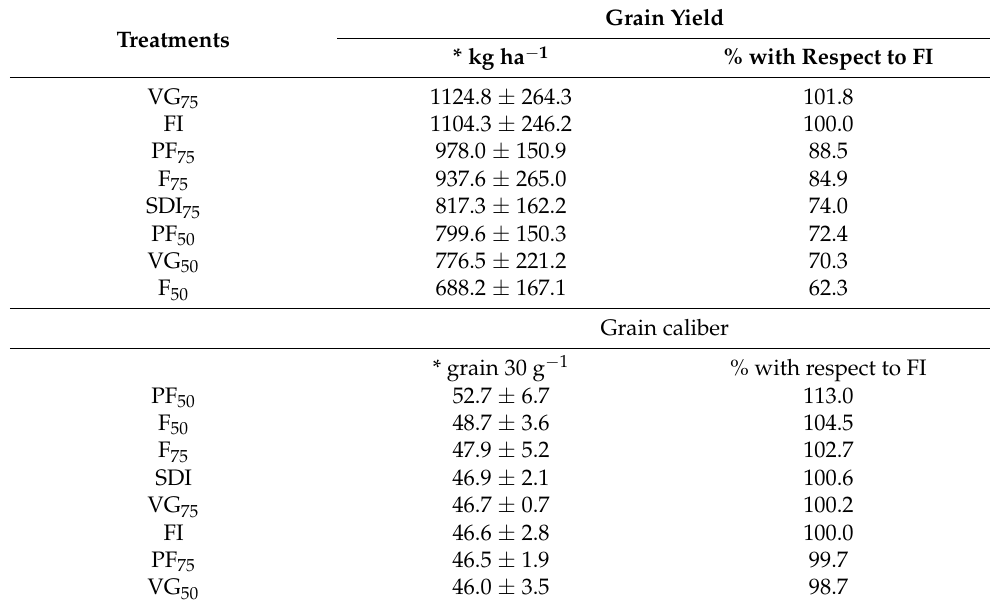
Table 6. Differences (%) in grain yield (GY) and caliber (Cal) among irrigation treatments. Treatments